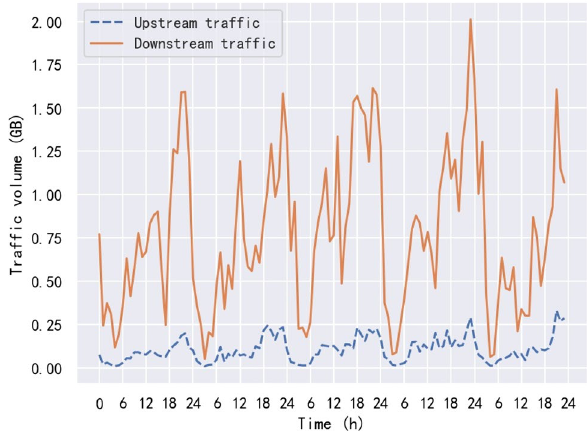
Fig. 1 Time variation of upstream and downstream traffic